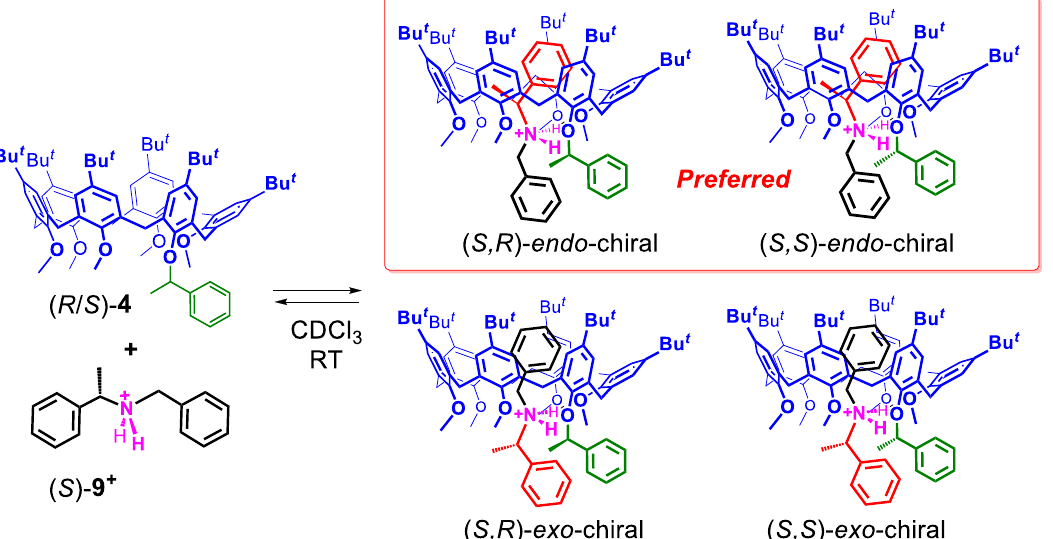
Figure 4. DFT-optimized structures of 8 + @ ( R )- 4 pseudo[2]rotaxane at the B97D3/SVP/SVPFIT level of theory.